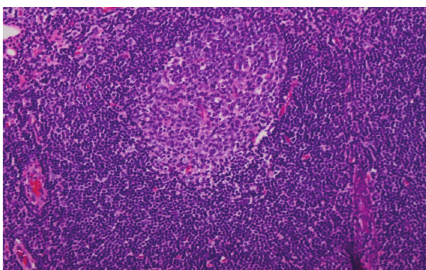
Figure 5: High Power Field. Reactive germinal center. Note the “polarization” ofthefollicle. Thedark zone(atthetopinthispicture) is made up of immature lymphocytes (ie, centroblasts), and the light zone (at the bottom in this picture) is made up of more mature centrocytes which mature and then move out into the mantle and marginal zones further to the